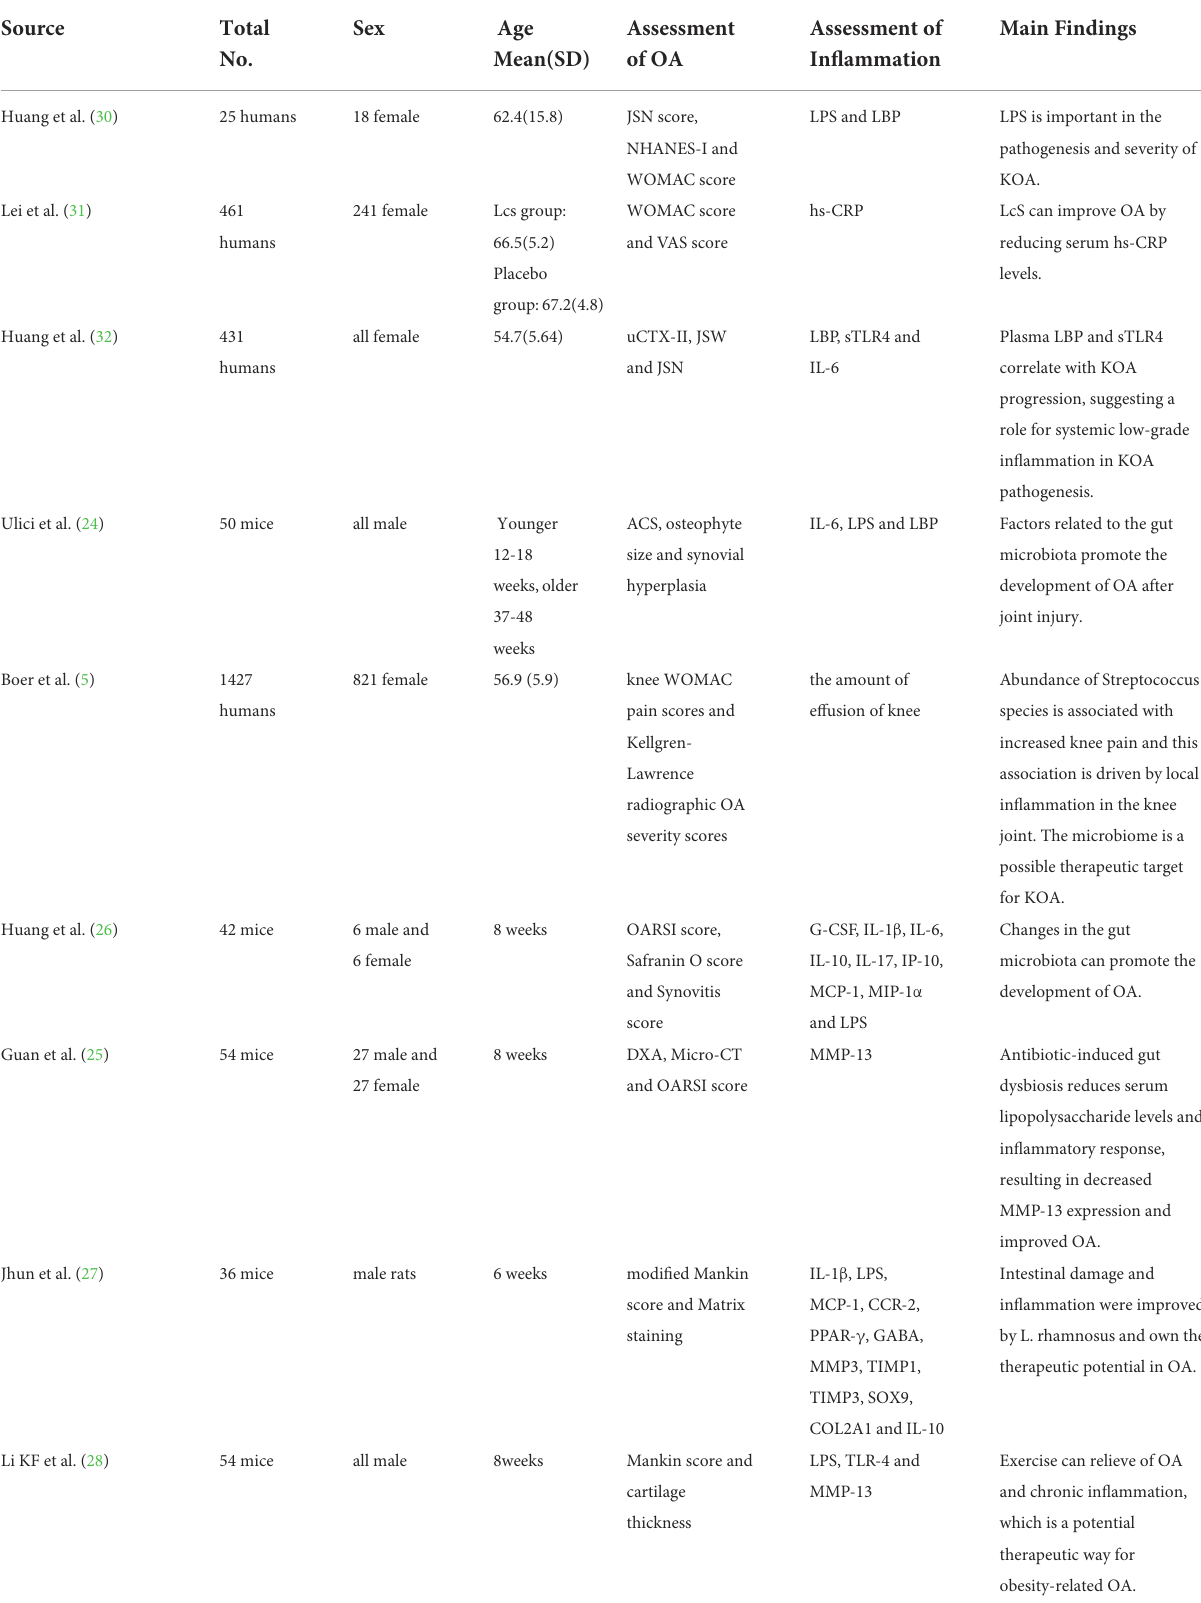
TABLE 1 The main findings of the included